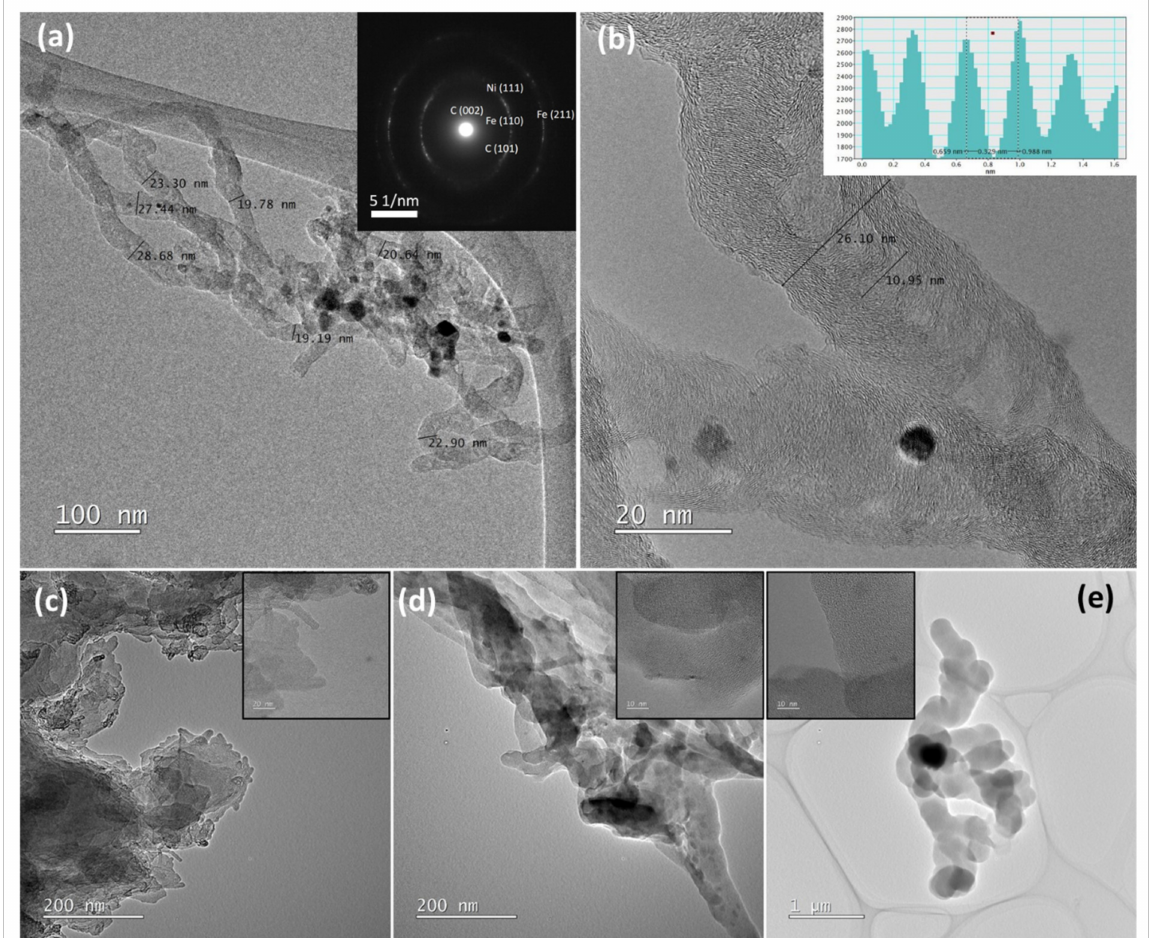
Figure 12. HRTEM images of the samples synthesized at 800 ◦ C. ( a ) Low magnification image of CNTs (inset is corresponding SAED pattern), ( b ) high magnification image of CNTs (inset is corresponding lattice profile), ( c ) bundles of short CNTs, ( d ) amorphous carbon nanofiber and ( e ) chaplet shape of the amorphous carbon.